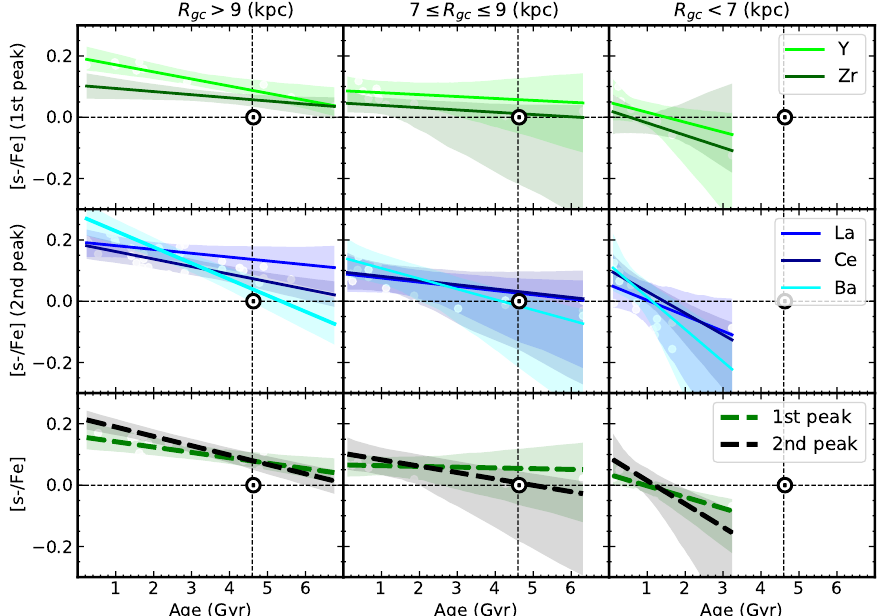
Figure 2. [El/Fe] versus age for the elements of the first peak (Y and Zr, upper panels ), of the second peak (Ba, La, Ce, central panels ), and average of first and second peak ( bottom panels ) in three Galactocentric bins (outer disc, R GC > 9 kpc; solar neighbdourhood 7 ≤ R GC ≤ 9 kpc; inner disc, R GC < 9 kpc). The curves are the weighted linear fits to the data. The data of individual clusters are shown in transparency in each